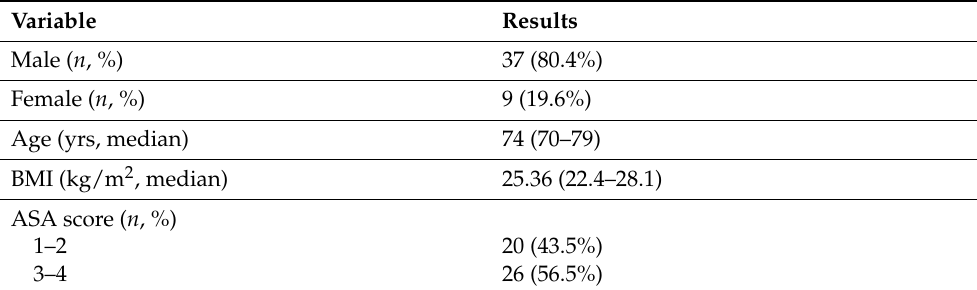
Table 1. Clinical and baseline